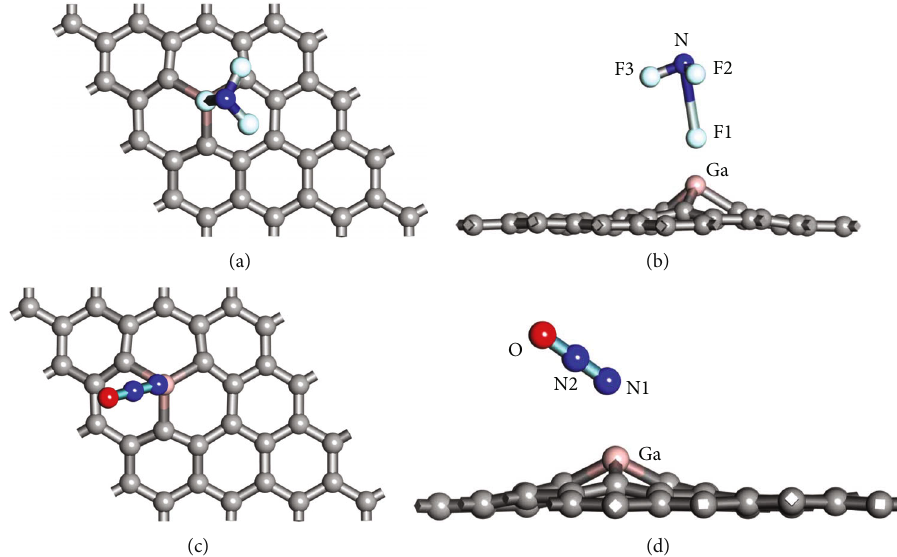
Figure 13: The adsorption con fi guration of NF view; (d) X2 side view).